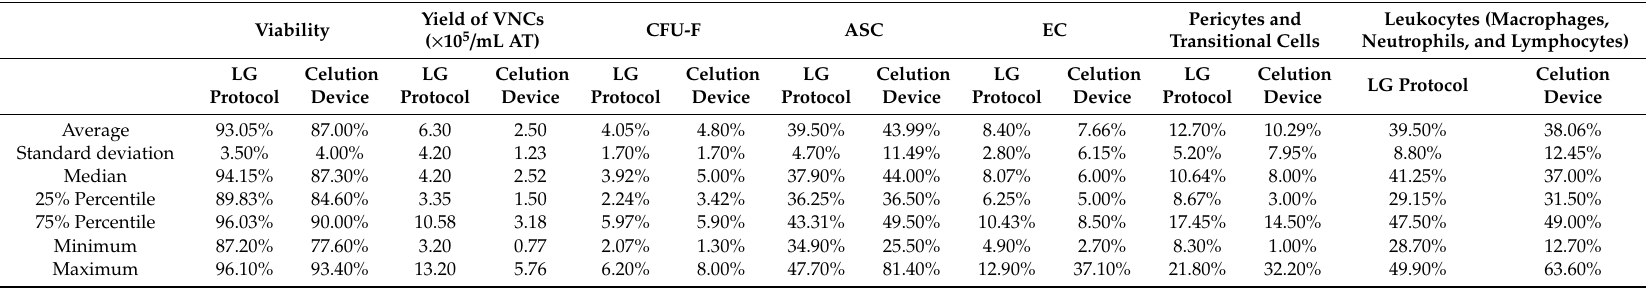
Table 2. Inter-donor comparative analysis of SVF produced using the Celution device or LG protocol. Detailed data of the 33 SVF products obtained with the